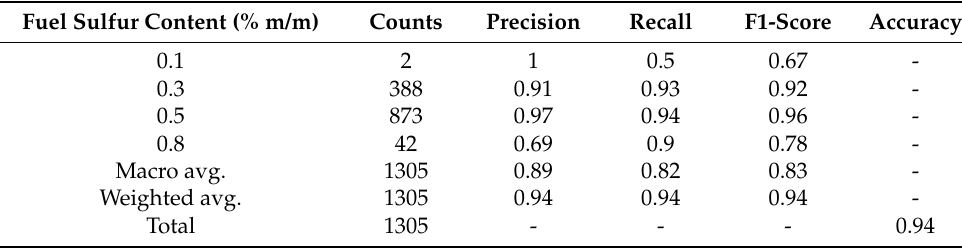
Table 4. Model evaluation report for 310 nm.